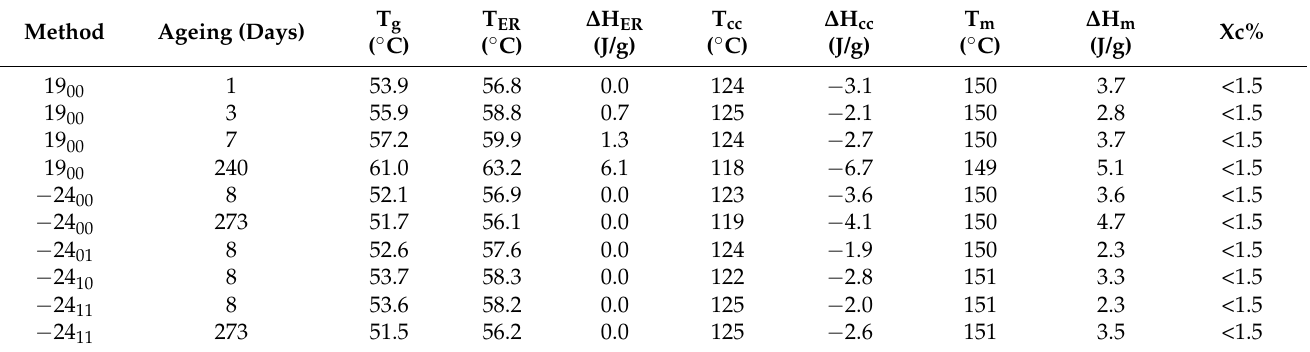
Table 2. Thermal properties of the extruded 1D PLA. T g : glass transition; T ER : enthalpic